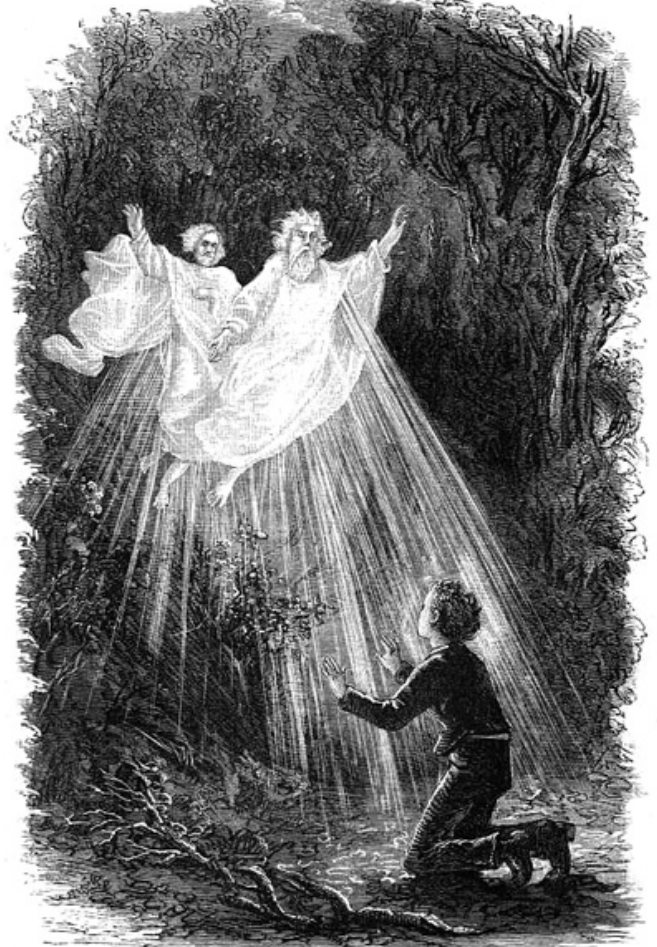
Figure 8. Joseph Smith’s First Vision by Unknown Artist, 1873. Published in Thomas Brown Holmes Stenhouse’s The Rocky Mountain Saints . Stenhouse 1873. New York: D. Appleton and Company, p. 5 .